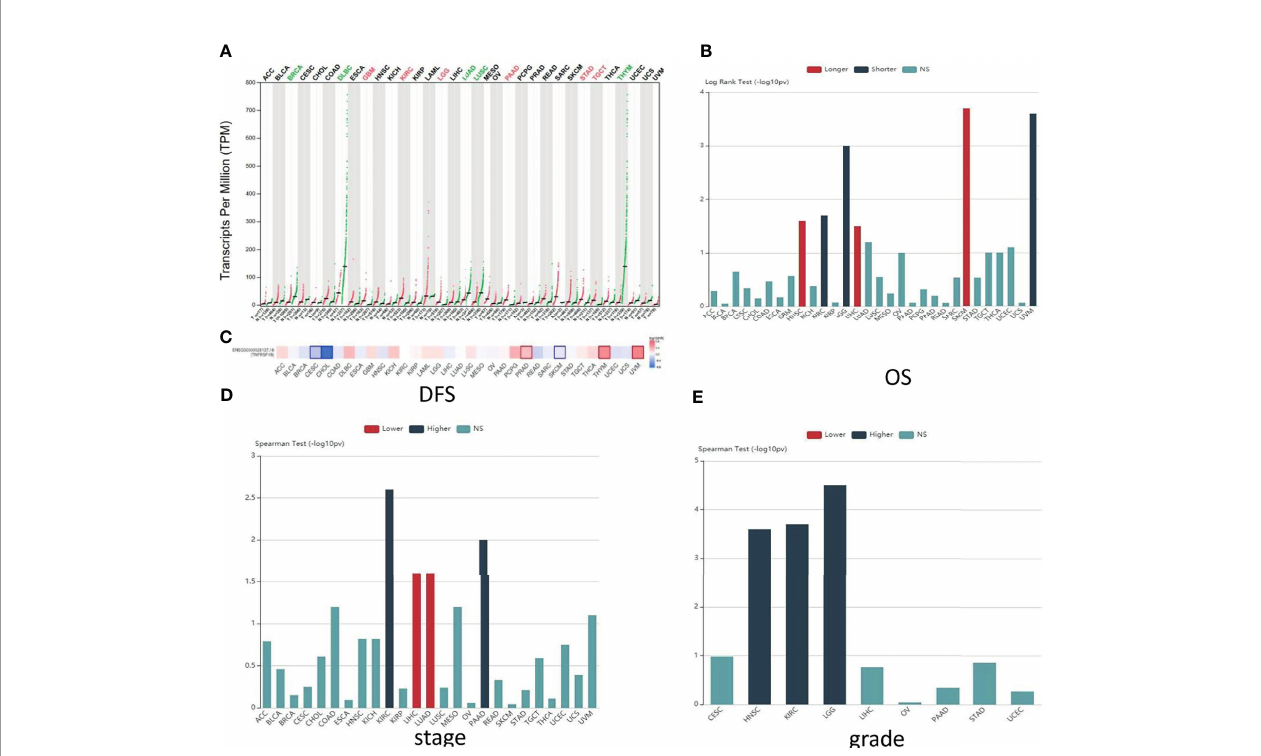
FIGURE 2 | Predictions of TNFR2 function in various cancers. (A) The TNFR2 expression pro fi le across all tumor samples and paired normal tissues from the TCGA database through GEPIA. Each dot represents expression in samples. The red font represents the signi fi cantly high expression of TNFR2 in the tumor, and the green font represents the signi fi cantly low expression (P < 0.05). (B) Analysis of the relationship between the expression of TNFR2 and the overall survival (OS) of various cancer patients from the TCGA database through TISIDB. The red bar (longer) indicates a correlation between higher TNFR2 expression and better overall survival rates for cancer patients; the green bar (shorter) indicates a correlation between higher TNFR2 expression and decreased cancer patient overall survival rates; the blue bar (NS) indicates that the TNFR2 expression level is not correlated with the overall survival rate of cancer patients. (C) TNFR2 expression is related to patient disease-free survival (DFS) in various cancers. Data were obtained from the TCGA database through GEPIA (P < 0.05). The red represents a positive correlation between TNFR2 expression and disease-free survival in cancer patients, and the blue represents a negative correlation. (D, E) Using large-scale RNA-Seq data sets of multiple cancer types from the TCGA database, we analyzed the relationship between TNFR2 expression and tumor stage and grade through TIBIS prediction. The red bar (lower) indicates a correlation between higher TNFR2 expression and a lower stage or grade of cancer; the green bar (higher) indicates a correlation between higher TNFR2 expression and an increased cancer stage or grade; the blue bar (NS) indicates that the TNFR2 expression level is not correlated with the stage or grade of